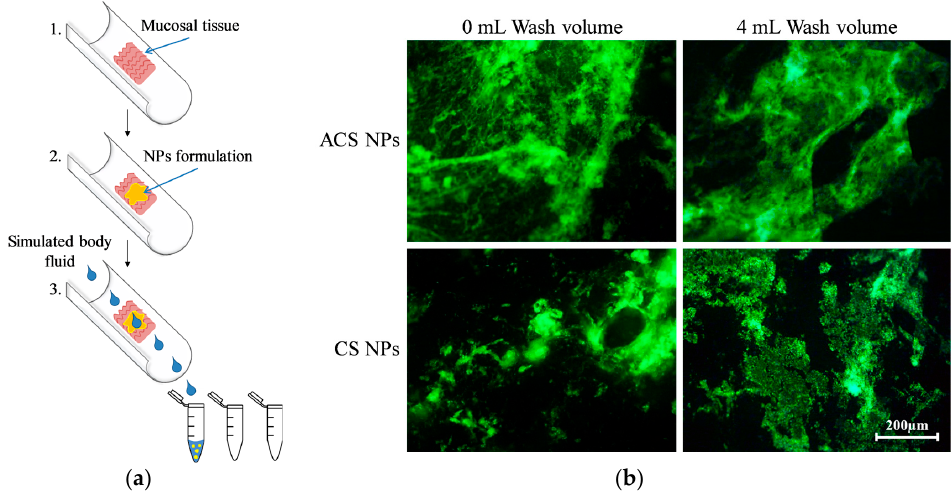
Figure 4. ( a ) Schematic representation of the flow-through method; ( b ) Fluorescent microphotographs of porcine intestine tissue samples with fluorescein isocyanate (FITC)-labeled ACS nanoparticles and CS nanoparticles, washed off with simulated intestinal fluid at a flow rate of 2 mL/min after incubation of 10 min.